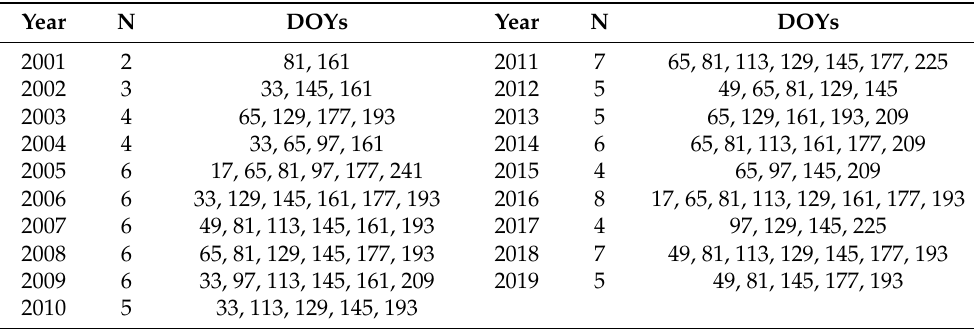
Table 2. A summary of the collected cloud-and shadow-free Landsat 5, Landsat 7, and Landsat 8 datasets available every year with their day of the years (DOYs) between the start and end of the seasons of WW and OSR from 2001 to 2019. N is the total number of Landsat scenes available per year for WW and